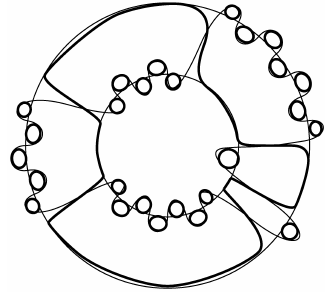
Fig. 3. Counting the Seifert circles after reversing a braid